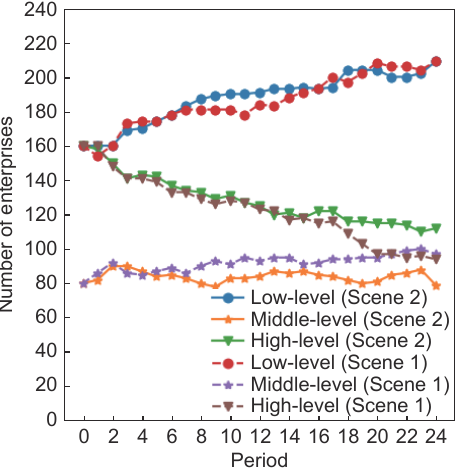
Fig. 5 Scenes 1 and 2: Changes of number of enterprises in Levels 4 and